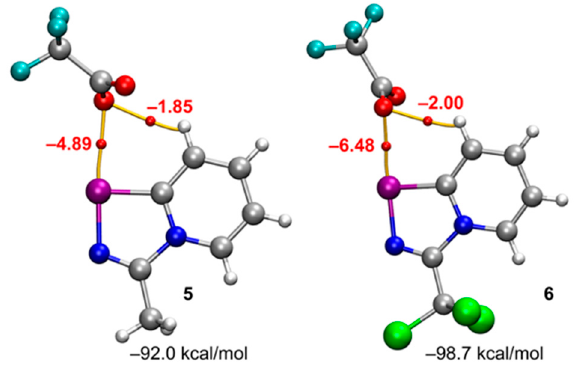
Figure 3. QTAIM analysis of compounds 5 and 6 . Only intermolecular bond CPs and bond paths are represented. The energies of the ChB and HB contacts are indicated next to the bond CPs (small red spheres) in kcal/mol.